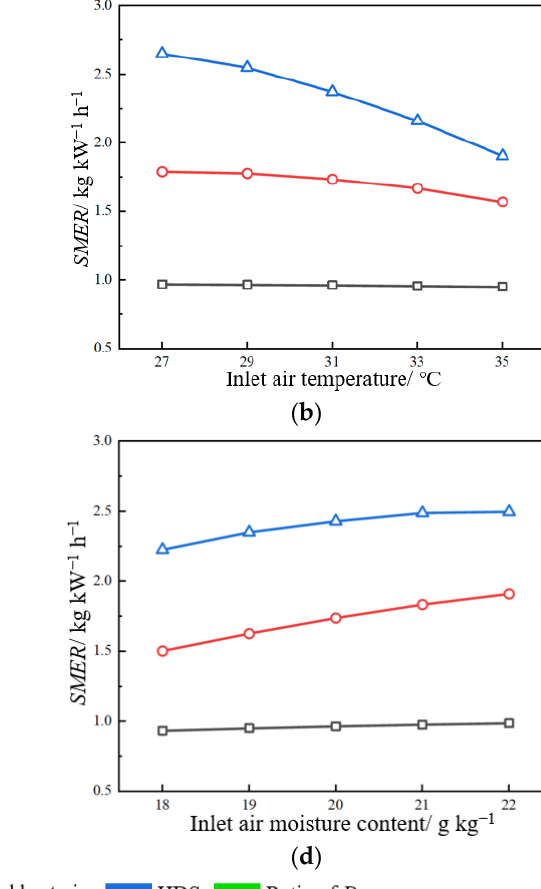
Figure 8. 𝐷 𝑐 and 𝑆𝑀𝐸𝑅 of three dehumidification systems . ( a ) 𝐷 𝑐 . ( b ) 𝑆𝑀𝐸𝑅 . ( c ) 𝐷 𝑐 . ( d ) 𝑆𝑀𝐸𝑅 .